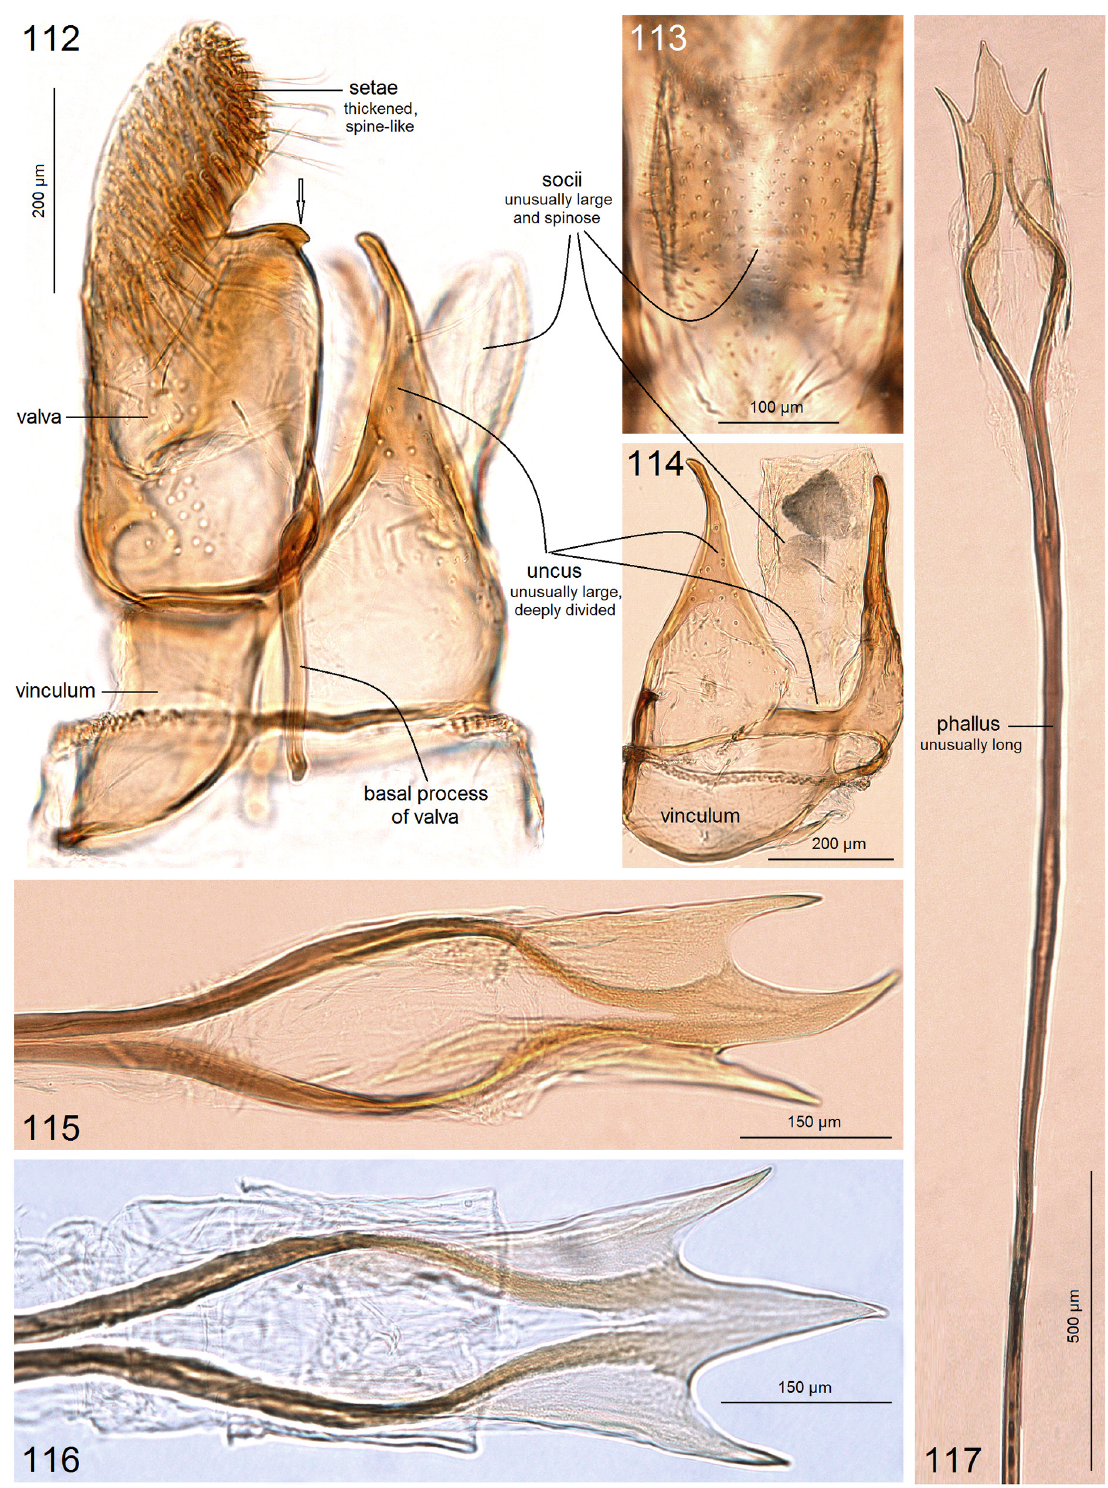
Figs 112–117. Male genitalia of Paratischeria tubifex Diškus & Stonis sp. nov. (NHMUK). 112 . Lateral view of capsule with phallus removed, paratype (genitalia slide no. 010316170). 113 . Socii, paratype (genitalia slide no. 010316172). 114 . Uncus, socii and vinculum, ventro-lateral view, paratype (genitalia slide no. 010316169). 115 . Same, apex of phallus. 116 . Apex of phallus, paratype (genitalia slide no. 010316170). 117 . Phallus, general view, holotype (genitalia slide no.